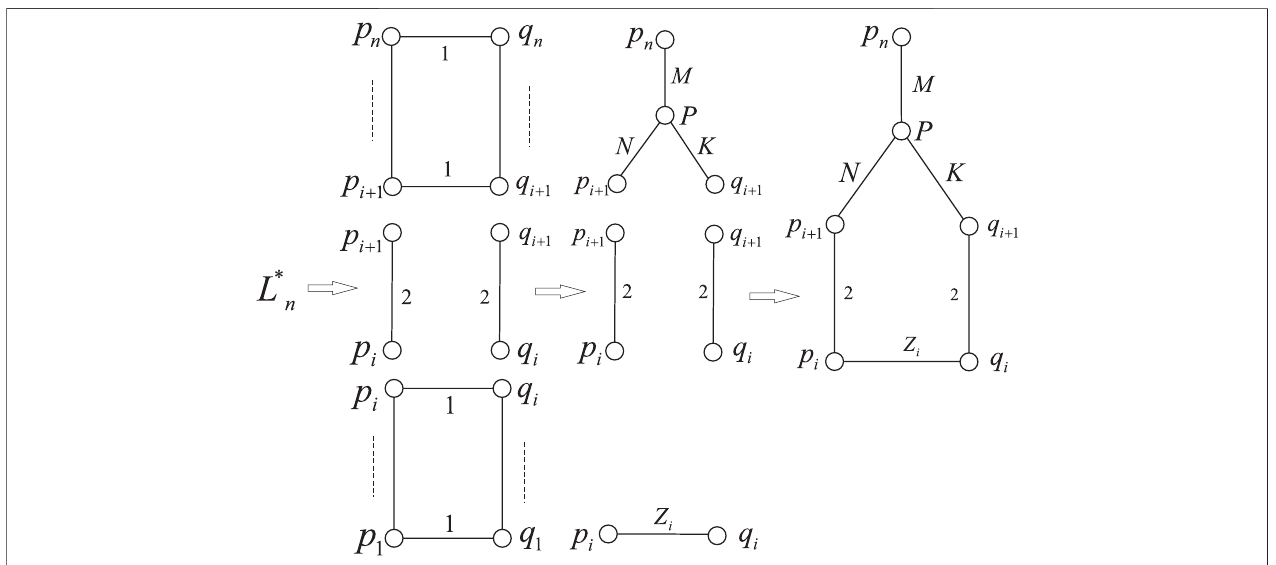
( p , p ) , Ω ( q , p ) , and Ω n i n i L * n n